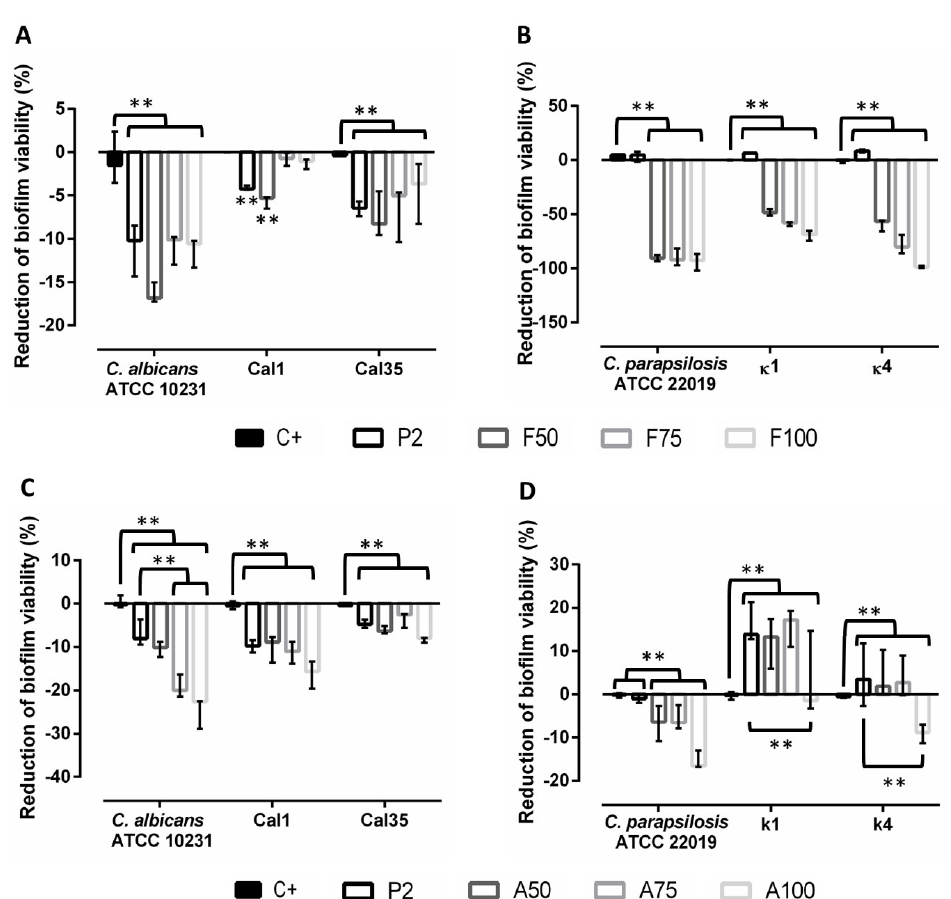
Figure 6. Percentage of reduction of biofilms treated with fluconazole-loaded coatings ( A , B ) or anidulafungin-loaded coatings ( C , D ). Comparisons with respect to positive control (without treatment) and P2. Data are represented as mean and standard deviation of the percentage of viability reduction estimated in at least three independent experiments. *: 0.05 > p > 0.01; **: p < 0.01 for t -test.